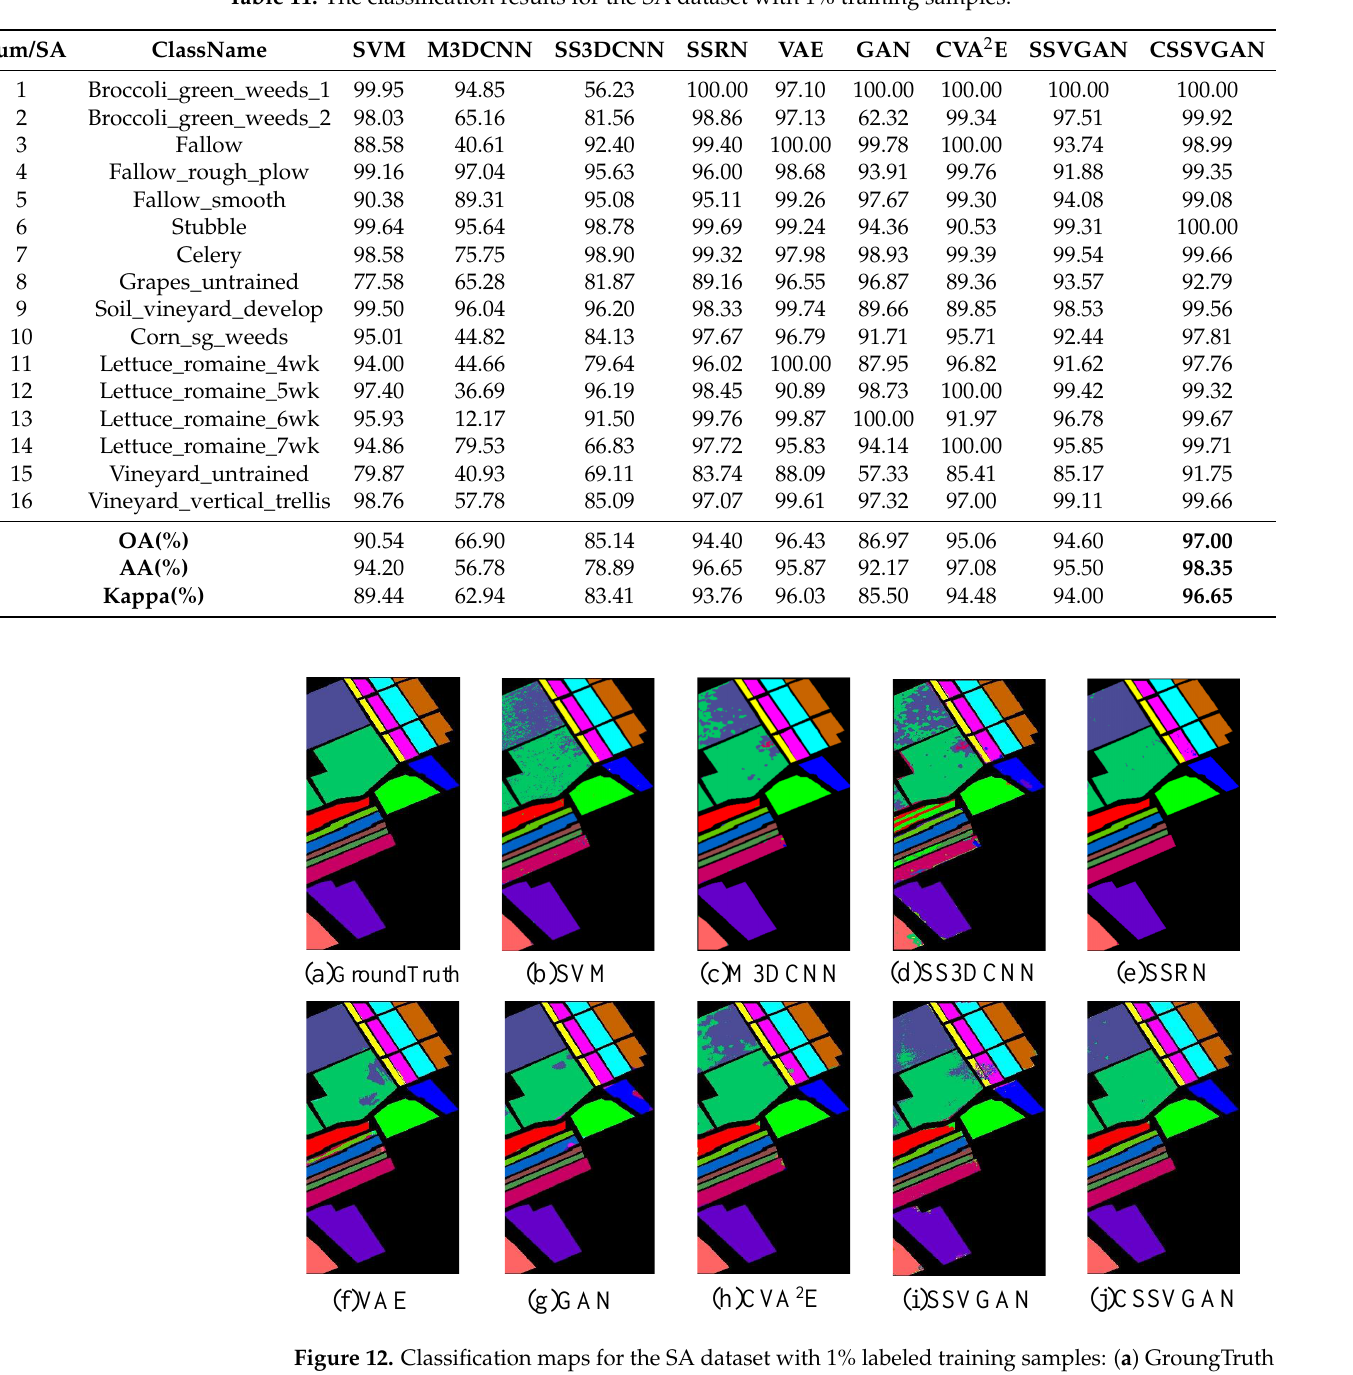
Figure 12. Classification maps for the SA dataset with 1% labeled training samples: ( a ) GroungTruth ( b ) SVM ( c ) M3DCNN ( d ) SS3DCNN ( e ) SSRN ( f ) VAE ( g ) GAN ( h ) CVA 2 E ( i ) SSVGAN ( j )